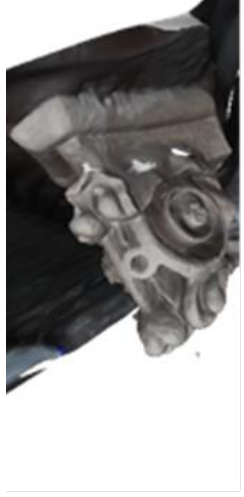
Figure 12: Corinthian capital – Photogrammetric